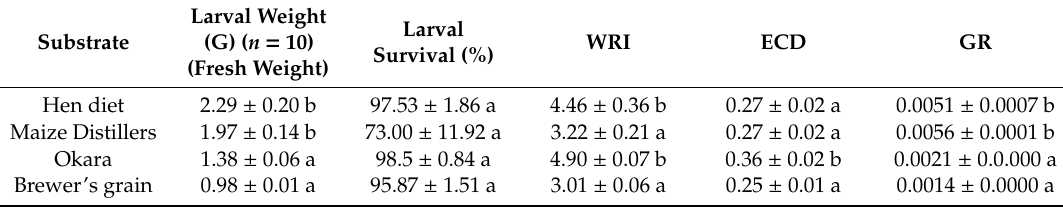
Table 3. Performance of larval growth and bioreduction of the substrates.